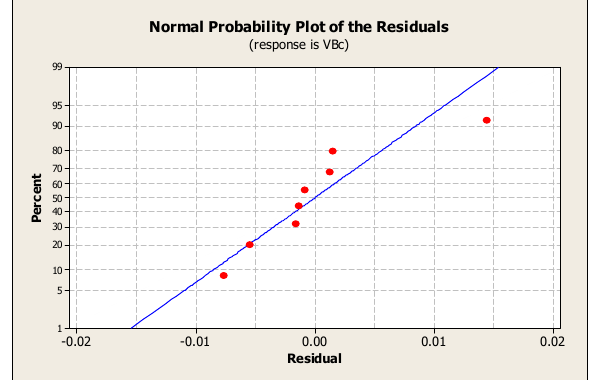
Fig. 3. Normal probability plot of the residuals